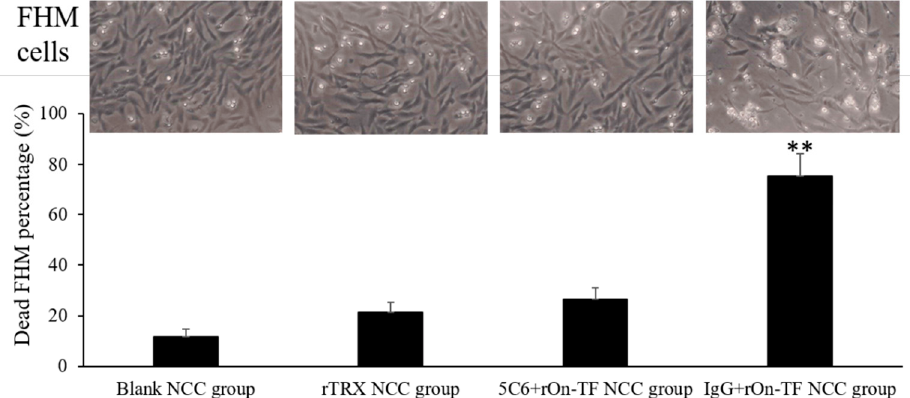
Figure 7. Cell-killing activity of NCCs on FHM cells. Photographs of FHM cells (upper) and corresponding dead cell percentage of FHM cells (lower). Data are shown as mean ± SE, and the significant difference is indicated by asterisks: ** p < 0.01.